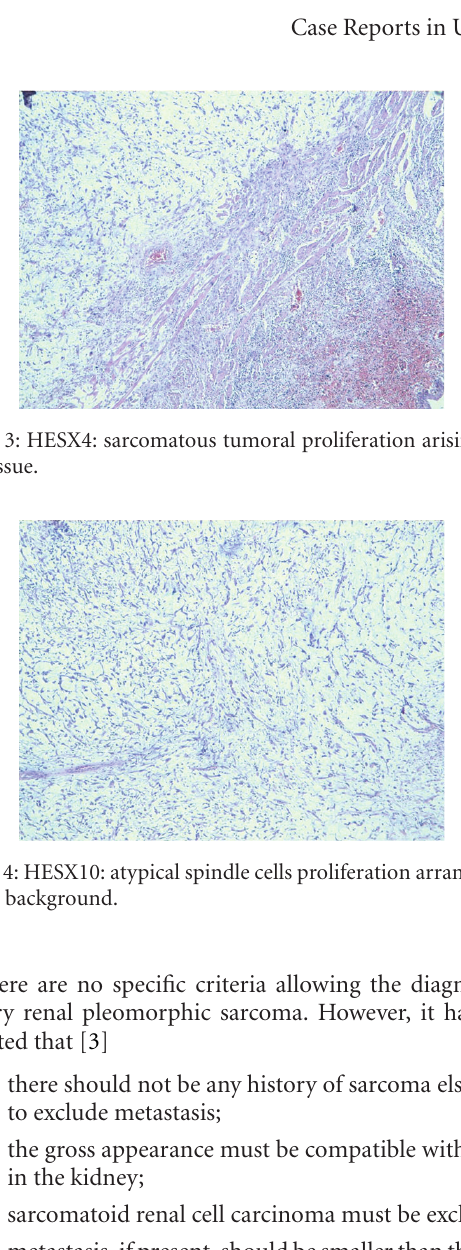
prognosis, the family decided to stop treatment. The patient died ten months later.